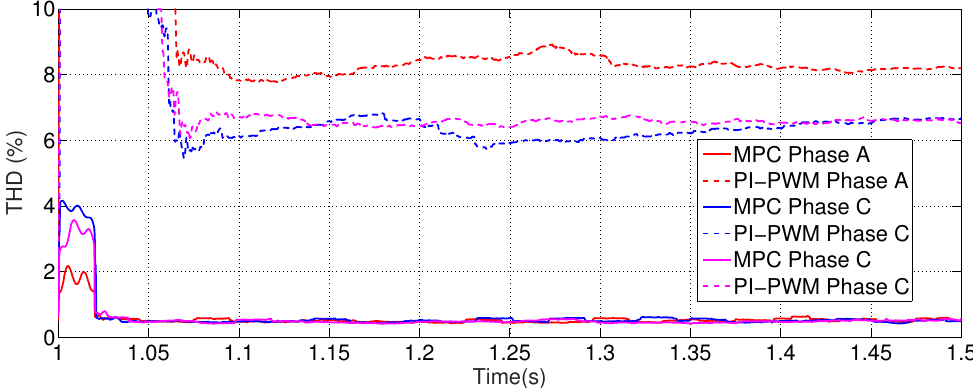
Figure 7. THD values for the voltages at the PCC during the blackout of the main grid.